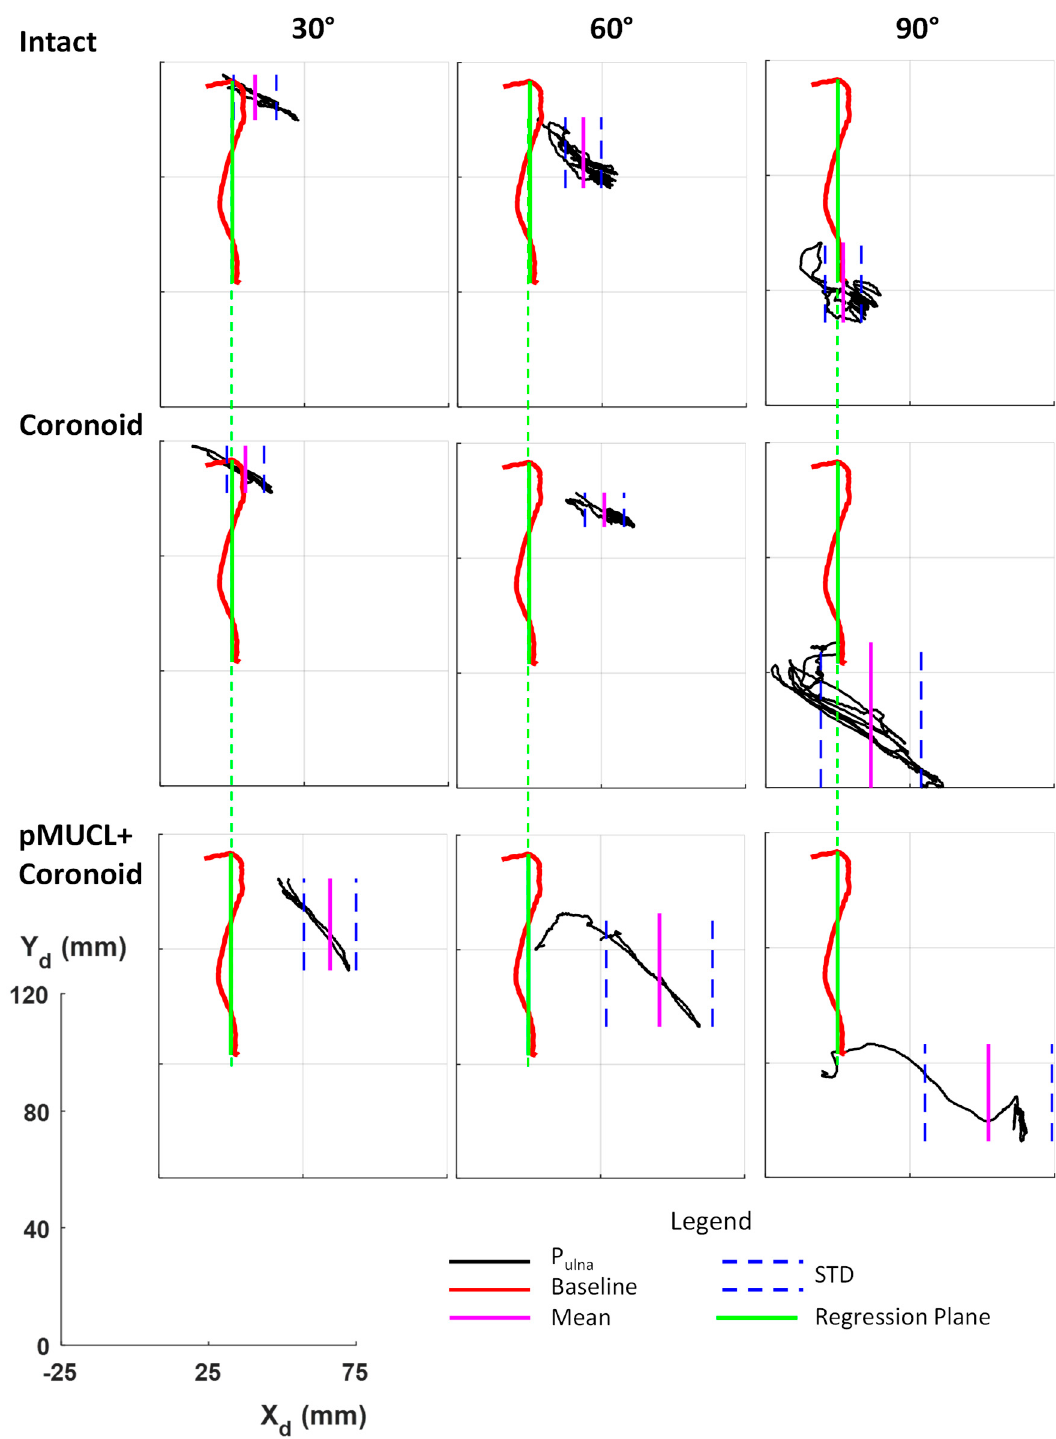
Figure 5. Elbow_2 stability for different surgical (intact, coronoid osteotomy and coronoid osteotomy + pMUCL section) and biomechanical (static flexion of 30°, 60°, 90°) conditions in transverse plane of the deflection coordinate system X d Y d . The red line depicts the baseline trajectory of physiological elbow flexion–extension motion with an intact elbow and the green line represents the regression plane. The lack line depicts the P Ulna trajectory during the orthopedic maneuver with mean and STD values highlighted as pink and blue lines, respectively. A common reference axis is reported to describe the measures of deflection (mm).